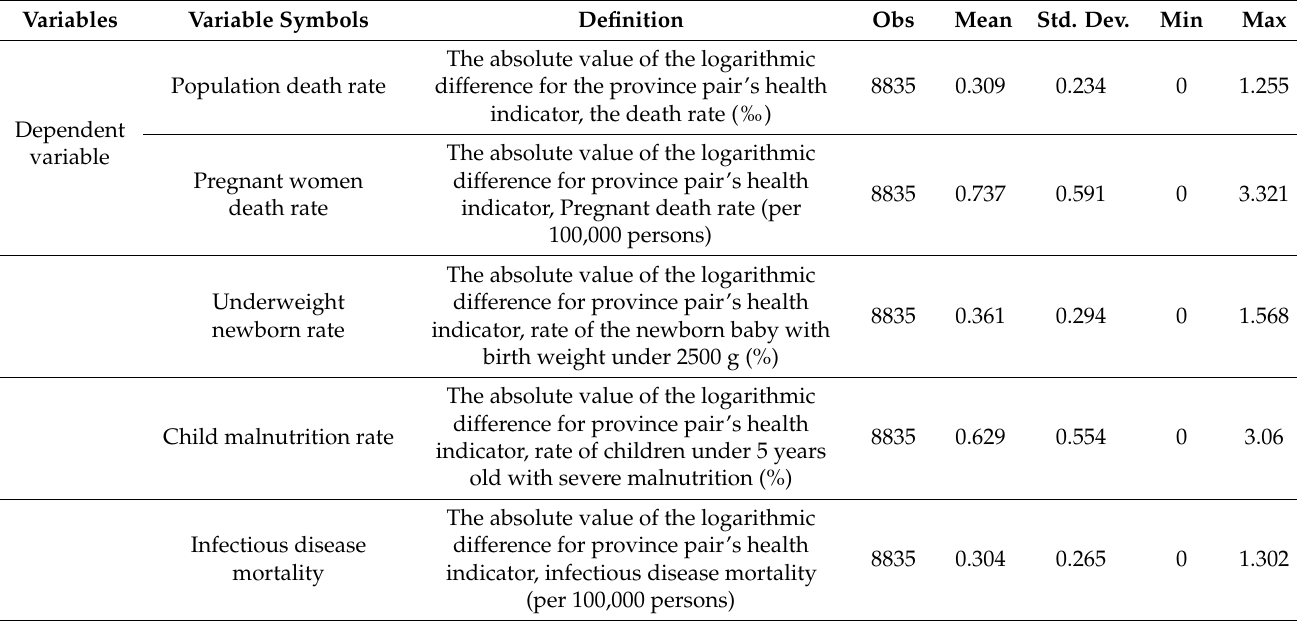
Table 2. Definitions of